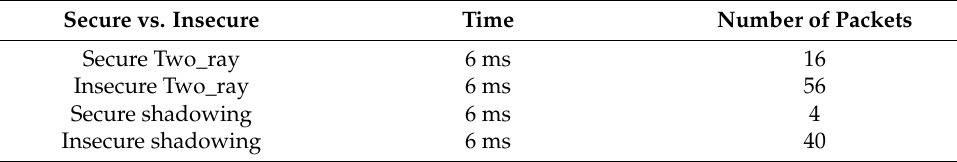
Table 8. The number of packets versus time in routing overhead parameter.